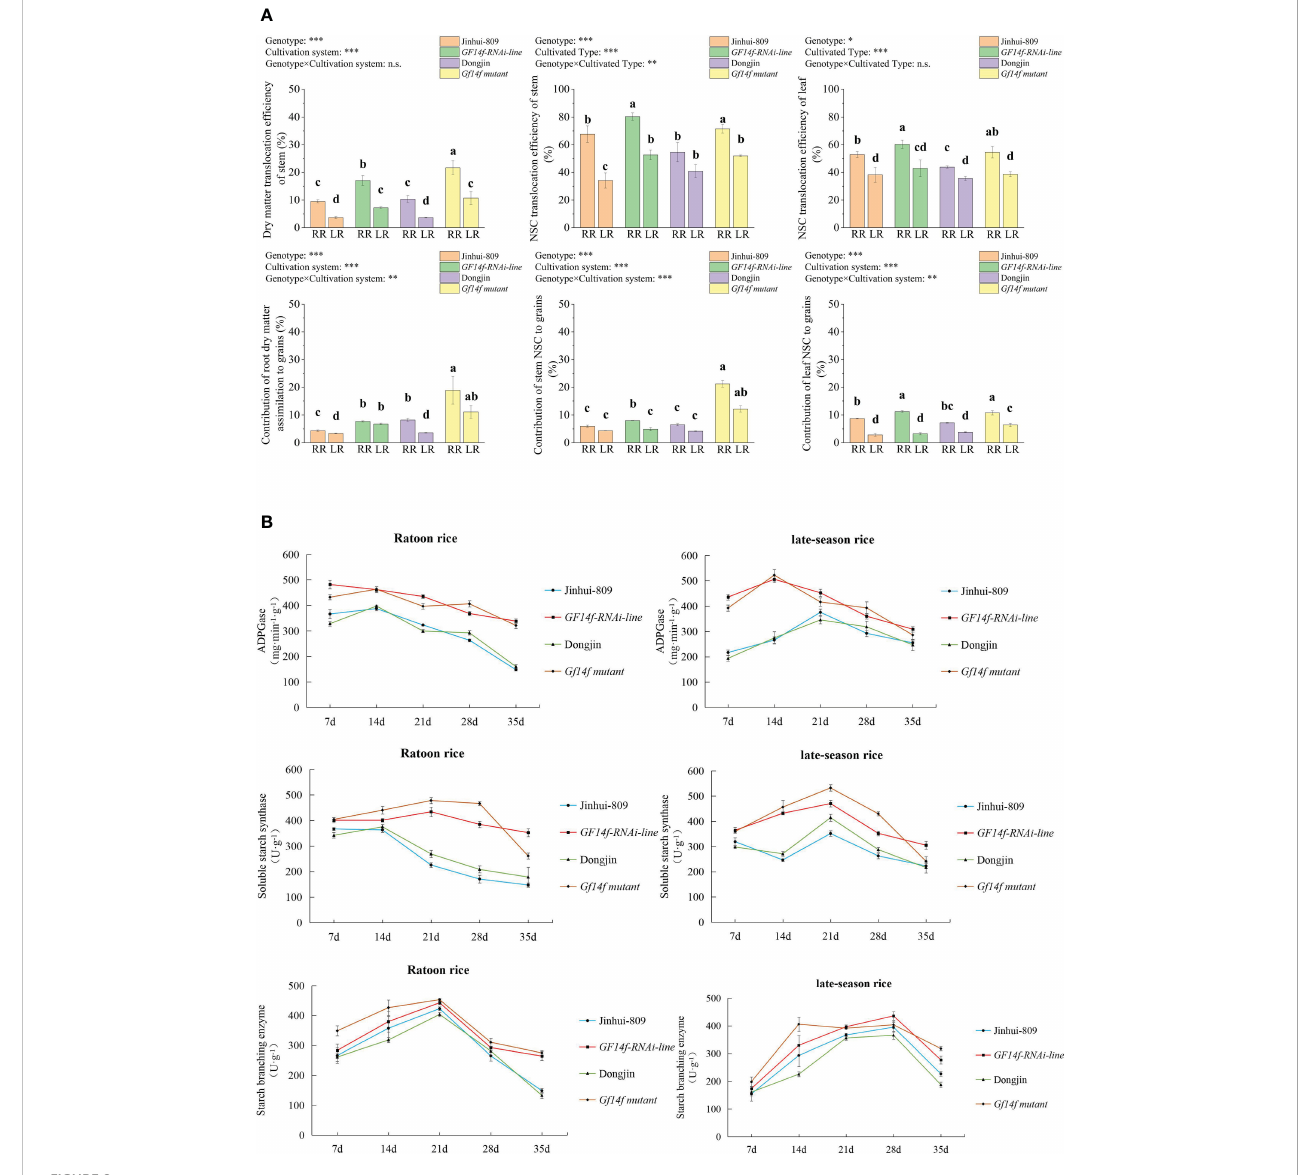
FIGURE 2 Comparisons in carbon reserve remobilization and sucrose-to-starch biosynthesis between GF14f-RNAi line , GF14f mutant and their WT. (A) : Carbon reserve remobilization in source tissues was mediated by the presence of the GF14f gene . Note: MR, RR and LR represent early-season rice, ratoon rice and late-season rice, respectively. Superscript letters indicate statistical groups that are signi fi cantly different ( P < 0.05 , ANOVA). Asterisks indicate factors contributing to the differences between samples (n.s., not signi fi cant; * P < 0.05 ; ** P < 0.01 ; *** P < 0.001 ). (B) : Starch biosynthesis were enhanced by suppression of the GF14f gene. ADPGase, soluble starch enzyme and starch branching enzyme were essential for sucrose-to-starch